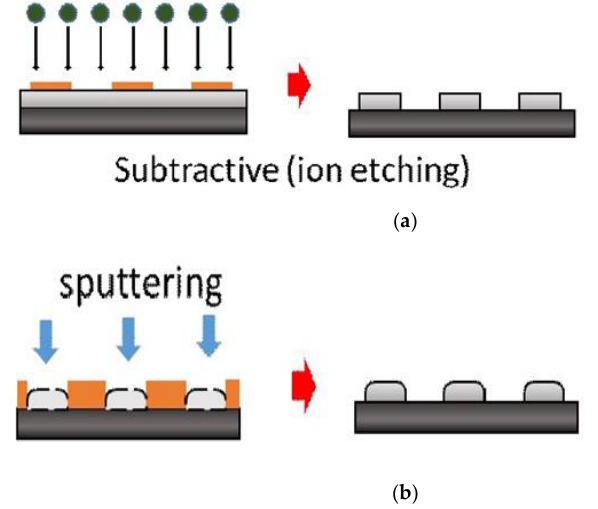
Figure 4. Illustrations of Al bump fabrication: ( a ) subtractive method and ( b ) additive method.